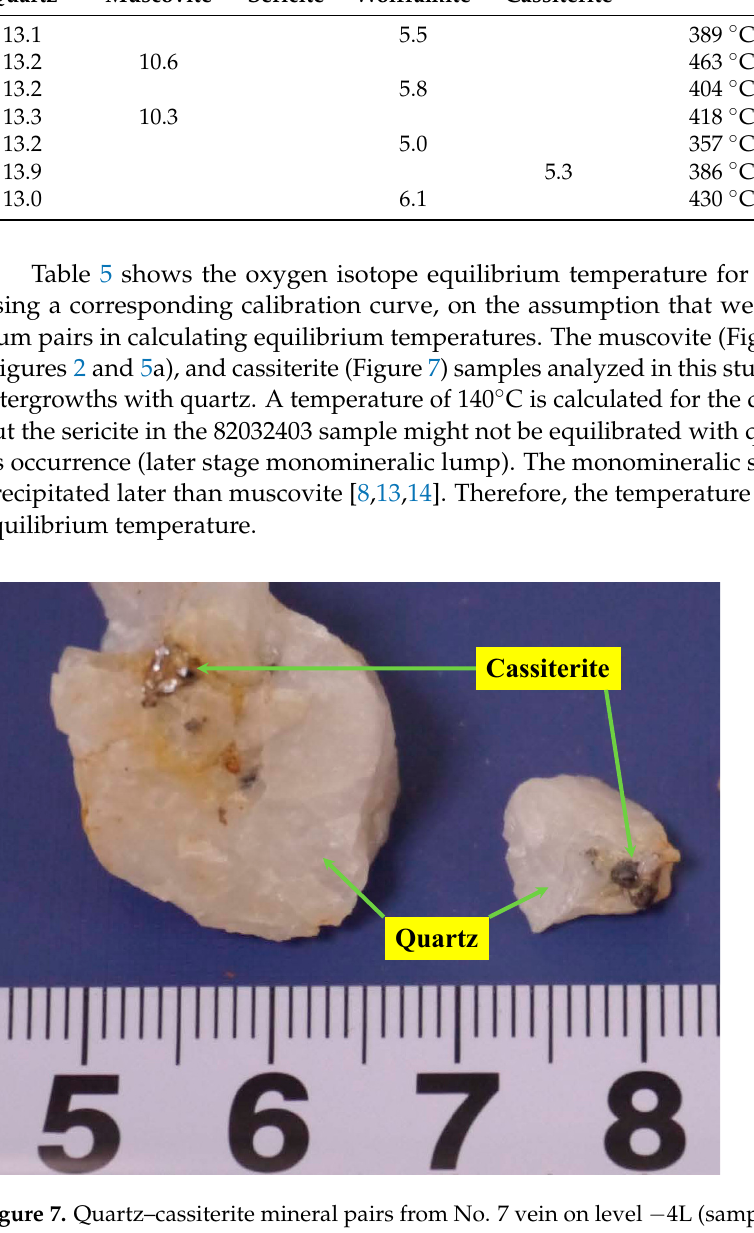
Figure 7. Quartz–cassiterite mineral pairs from No. 7 vein on level − 4L (sample 82032406, Table 1; Figure 4) of the Takatori deposit.